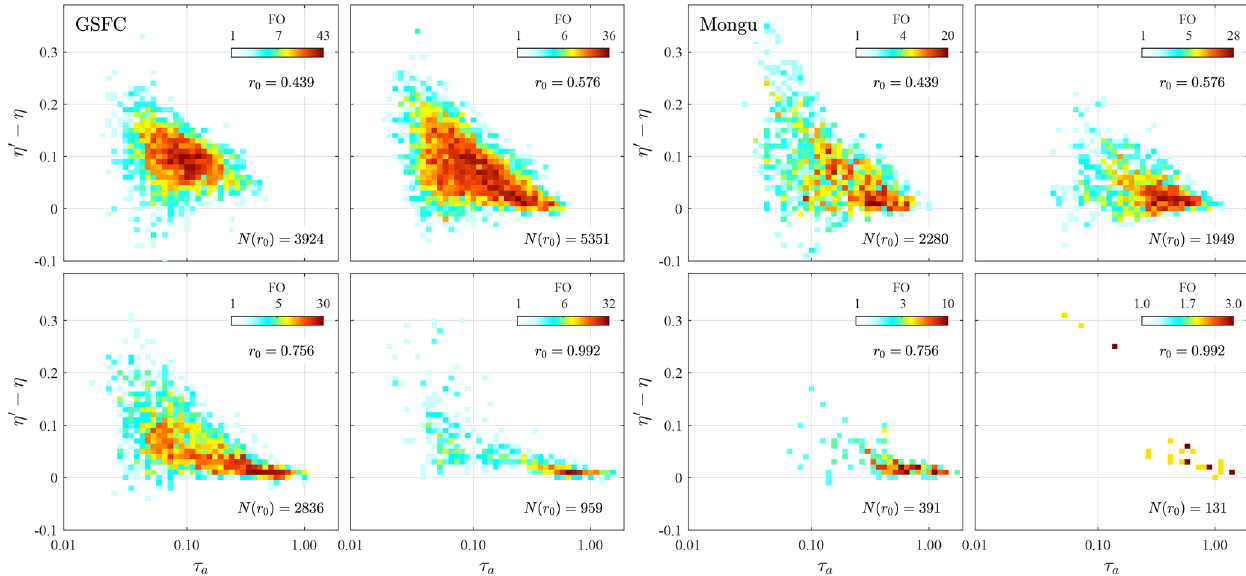
Figure 8. η (cid:48) − η vs. τ a FO distributions for GSFC and Mongu.